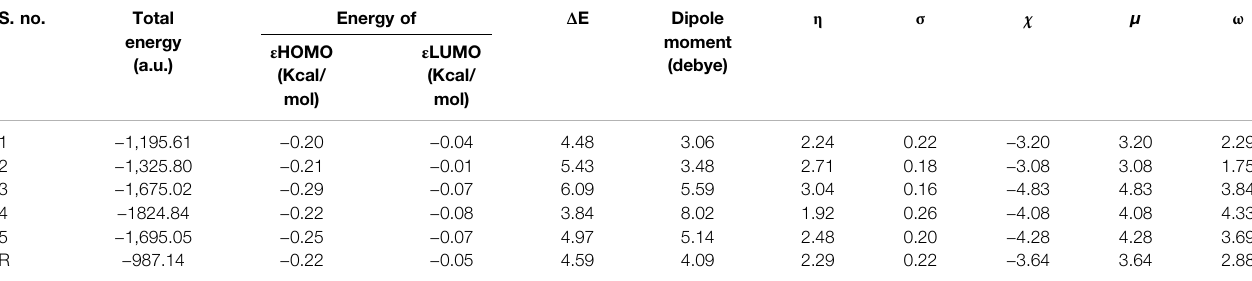
TABLE 13 | The statistical results of the DFT-based descriptors for the selected lead compounds and the drug. S.